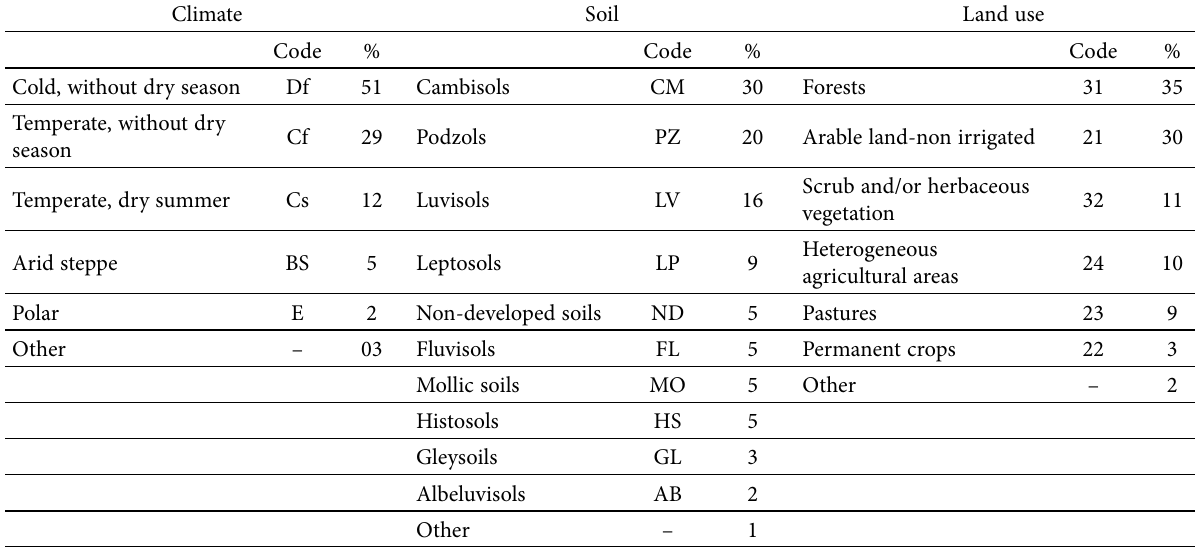
Table 1. Classes of climate, soil type, and land use that were selected for the representativeness analysis. For soils and climates, % indicates the proportion of the EU28 agricultural area. For land use, % indicates the proportion of the EU28 land area